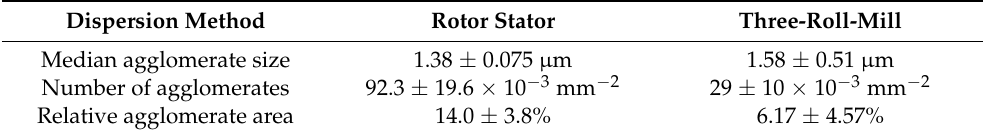
Table 5. Results of microscopic analysis of CA samples on PP